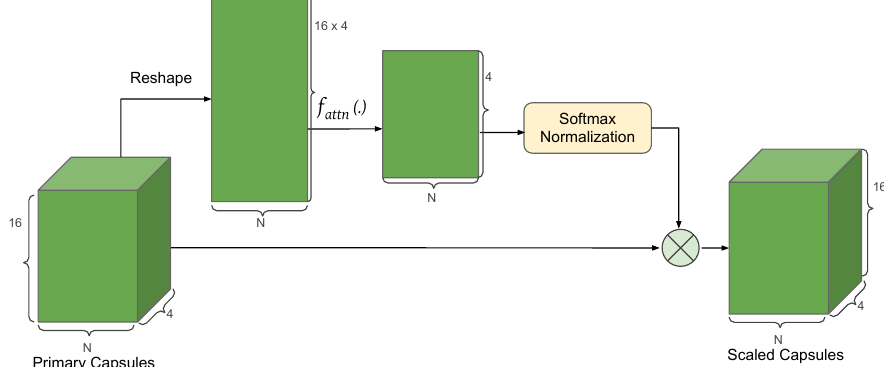
Figure 2. The structure of the attention module. ⊗ stands for